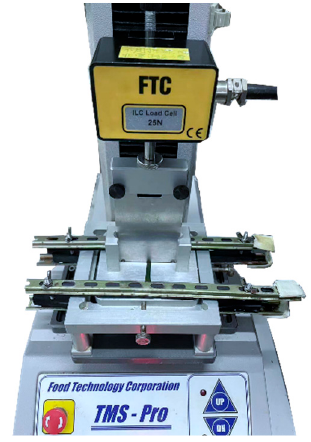
Figure 9. Schematic diagram of shear test device.